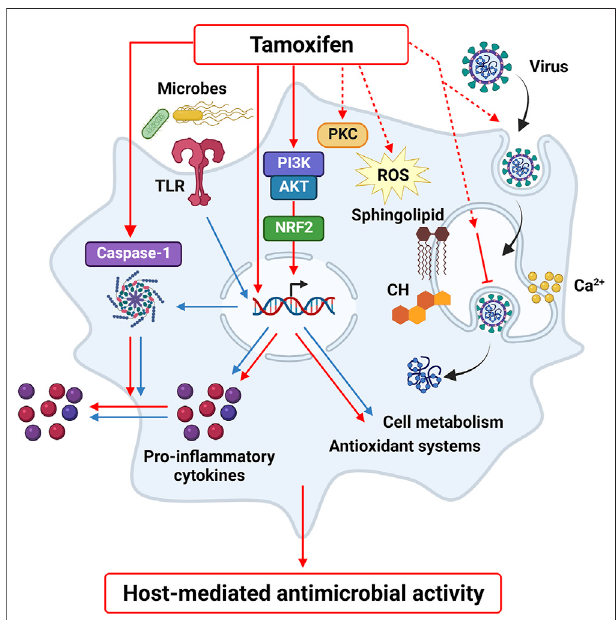
FIGURE 2 | Tamoxifen off-target effects in macrophages. Tamoxifen regulates macrophage activation by inducing PI3K-NRF2 pathway, caspase- 1 formation and by modulating lipid metabolism and calcium homeostasis, as well as other possible targets identi fi ed in other cell types, such as PKC and oxidative stress. These molecular mediators and cell responses may represent a host-mediated mechanism that contributes to the bene fi cial activity of tamoxifen against pathogen and viral